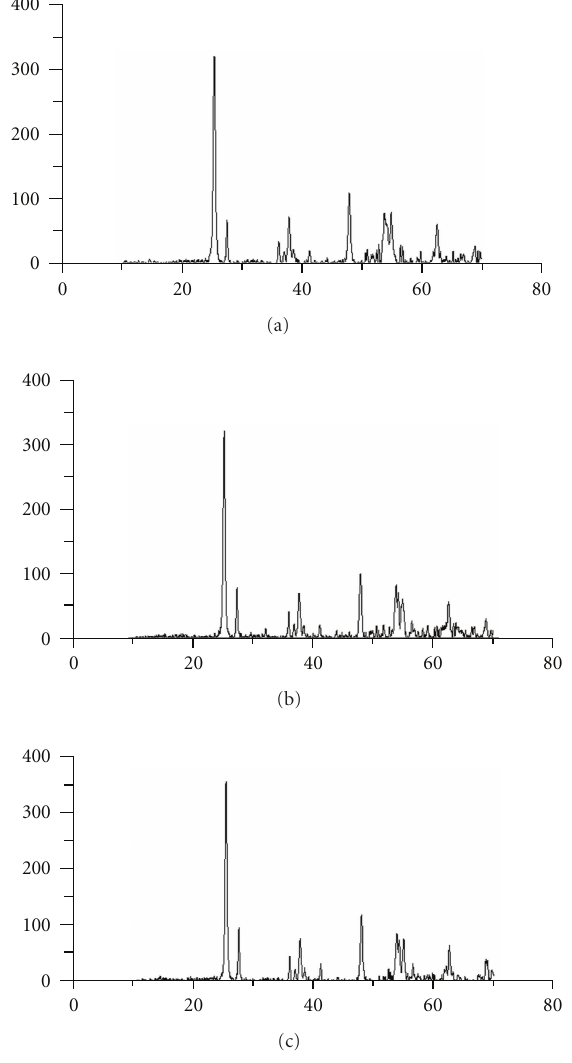
Figure 10: X-ray di ff raction patterns of catalysts: (a) TiO 2 (P25), (b) 5% Ag/TiO 2 , and (c) 5% Cu/TiO 2